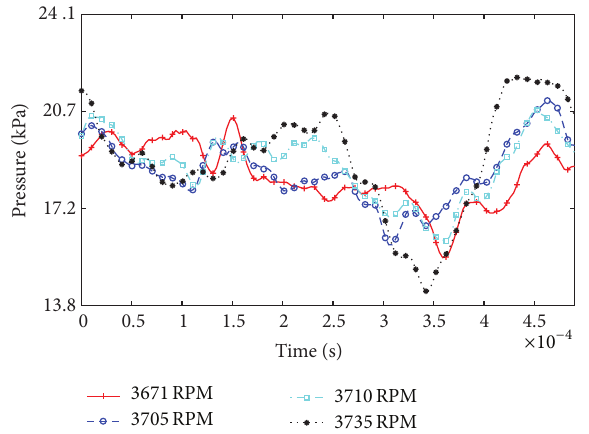
Figure 15: Rotor blade passage traces, Blade 26, PS 80% Span 20% Chord, HL.